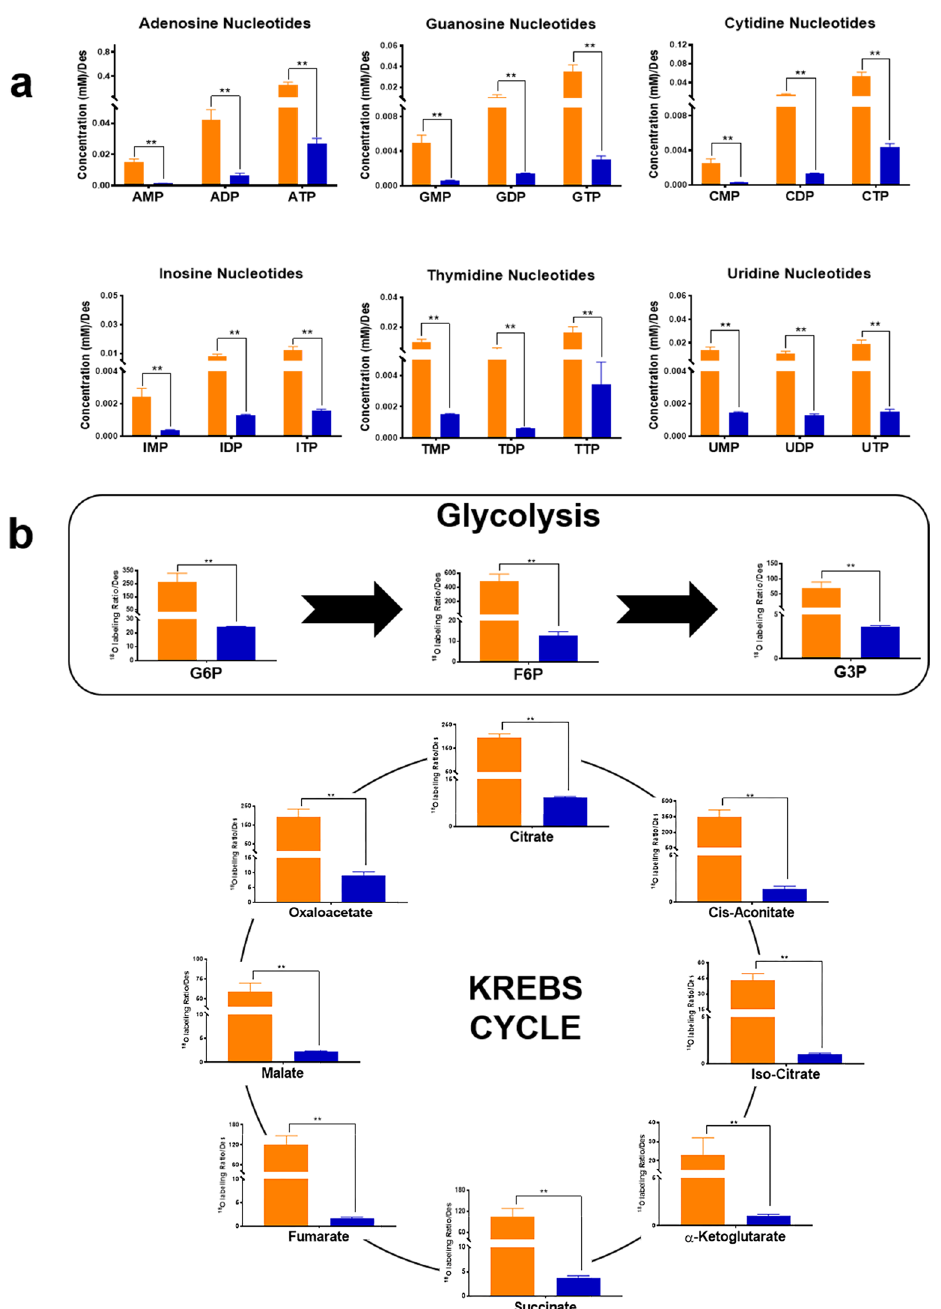
Figure 8. Metabolomic and fluxomic analysis in primary skeletal muscle cells of the Megaconial CMD patient. ( a ) The oligophosphonucleotide levels (mM/Desmin), ( b ) The 18 O labeling ratios of Krebs cycle metabolites in Megaconial CMD and control, ** p <